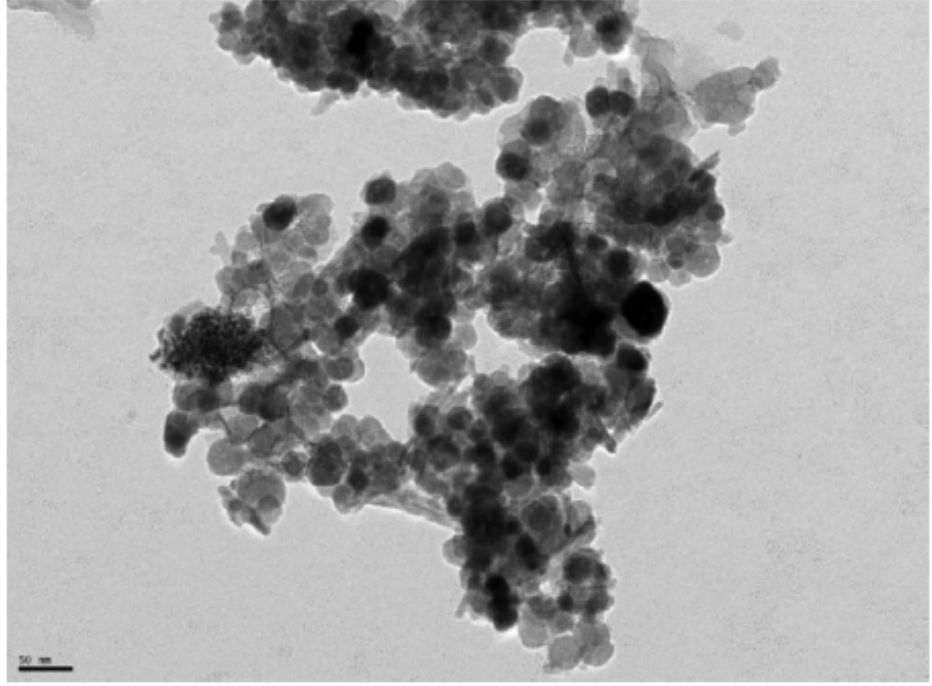
Figure 3. TEM image of [Fe Copyright 2012 Royal Society of